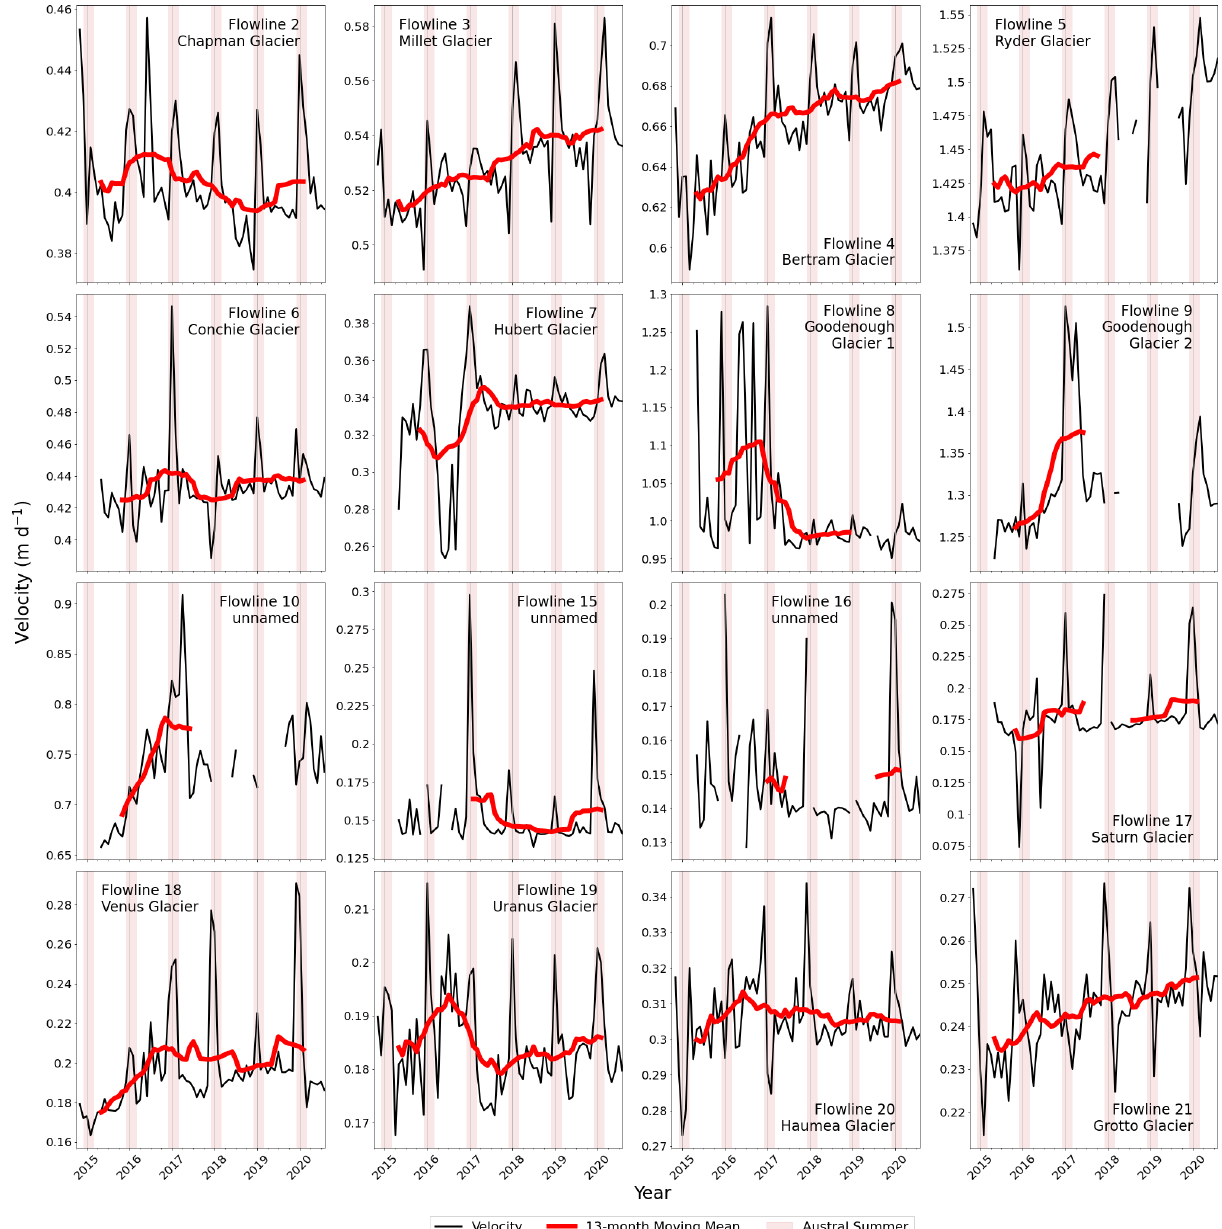
Figure 4. SAR-derived observations of ice flow for each month between October 2014 and August 2020 (black line) and the 13-month moving mean ice flow (red line). Observations are averaged across the 10km 2 dashed boxes shown in Fig. 1. Translucent red shading denotes the timing of austral summertime (December–February, inclusive). Note that the y -axis limits vary between